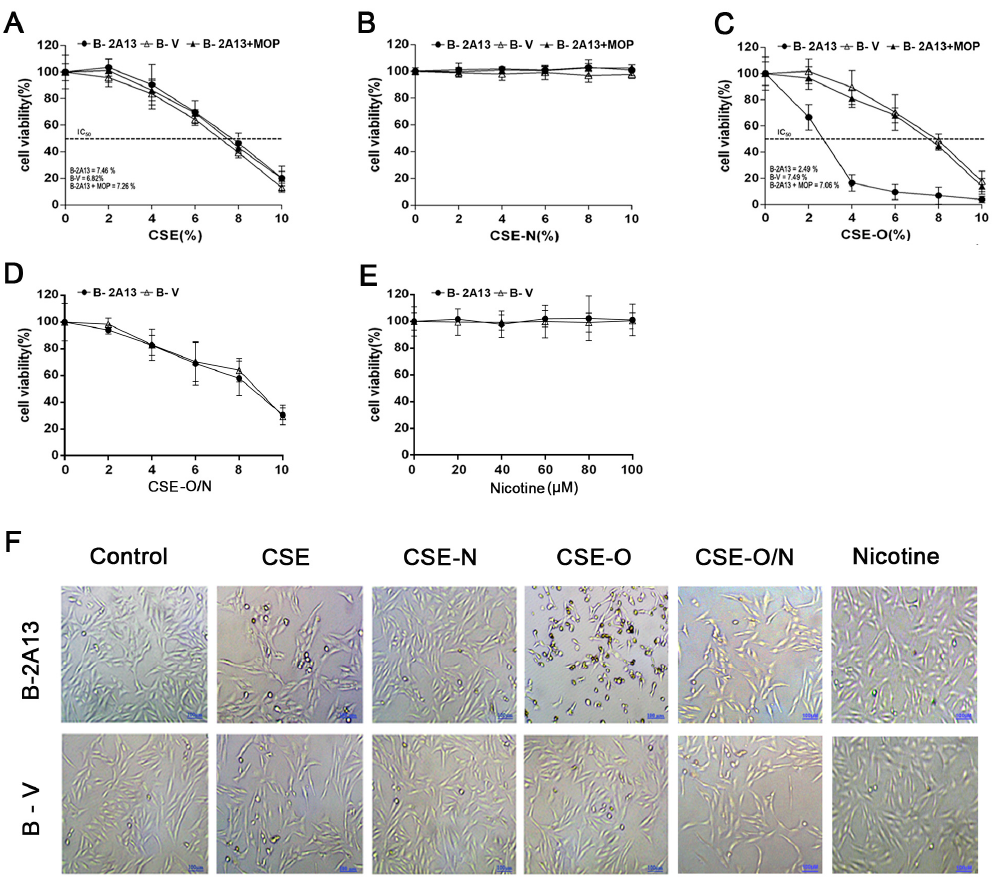
Figure 3. Cell viability of immortalized human bronchial epithelial (BEAS-2B) cells treated with cigarette smoke extract (CSE), nicotine section of CSE (CSE-N) and nicotine-free section of CSE (CSE-O). The cells were treated with CSE, CSE-N, CSE-O, CSE-O/N, or nicotine standard for 24 h, and a cell counting kit 8 (CCK-8) assay was used to determine cell viability. ( A ) CSE; ( B ) CSE-N; ( C ) CSE-O; ( D ) CSE-O/N; ( E ) nicotine standard; ( F ) representative photography of cells treated with 4% CSE, CSE-N, CSE-O, CSE-O/N, or nicotine standard (100 µ M). The data are presented as the mean ± SD of three independent experiments with triplicate samples; bar: 50 µ m.